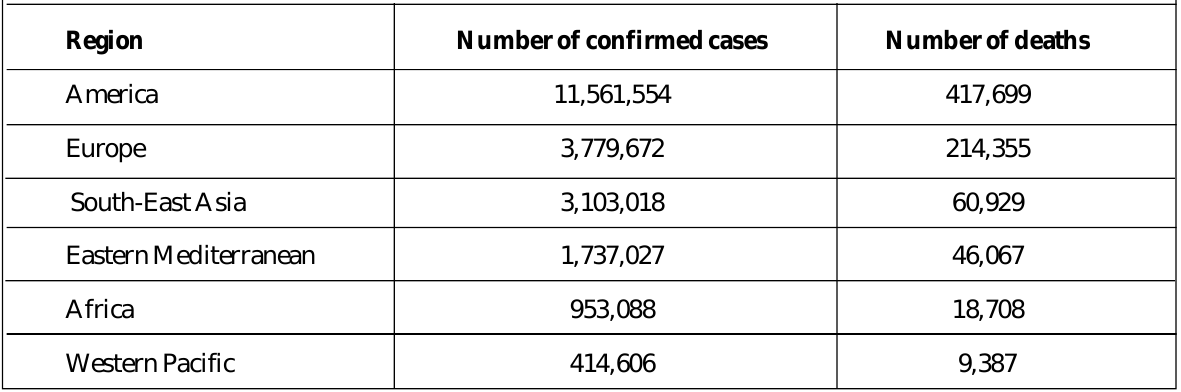
Table 1: The number of confirmed and deaths cases of COVID-19 outbreaks according to WHO situation reports August 17, 2020 by region